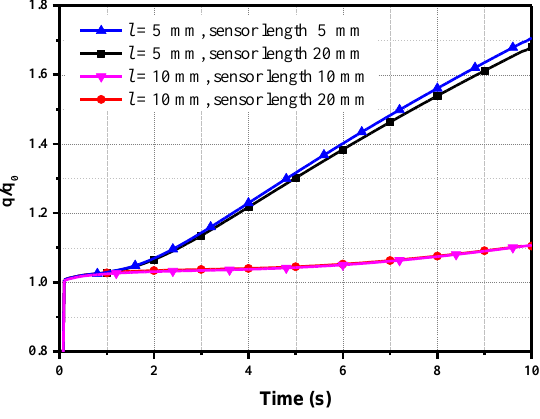
Figure 8. E ff ects of the sensor length on the heat Figure 8. Effects of the sensor length on the heat flux.